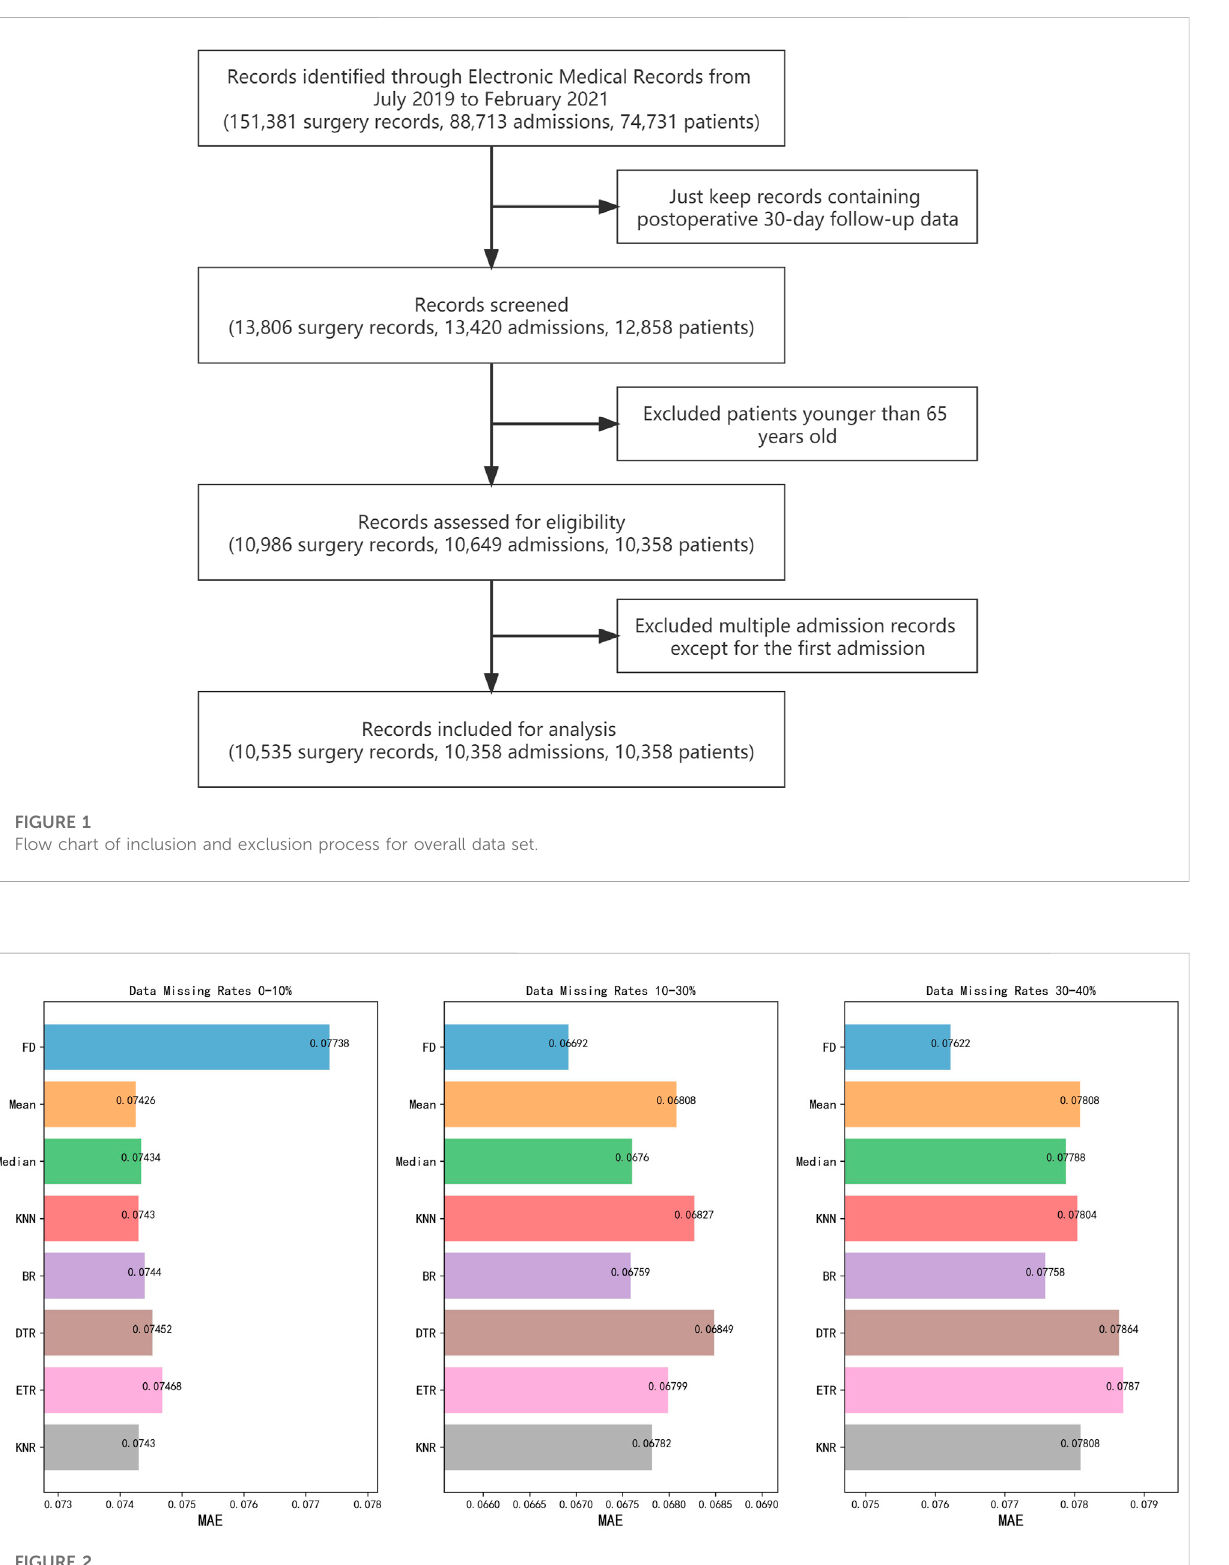
FIGURE 2 Imputationtechniquesindifferentmissingdatagroups.FD,Fulldata;KNN,knearestneighbor;BR,BayesianRidge;DTR,DecisionTreeRegressor; ETR, ExtraTreesRegressor; KNR, KNeighborsRegressor; MAE, Mean Absolute Error. BayesianRidge performed the best with the lowest MAE among all imputation